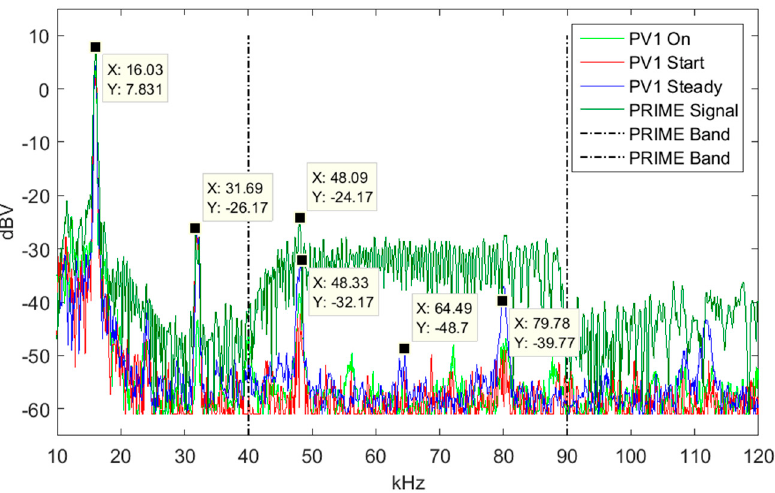
Figure 21. Spectrum recorded at PV1 inverter SM with the rest of inverters switched on and the battery charger disconnected.